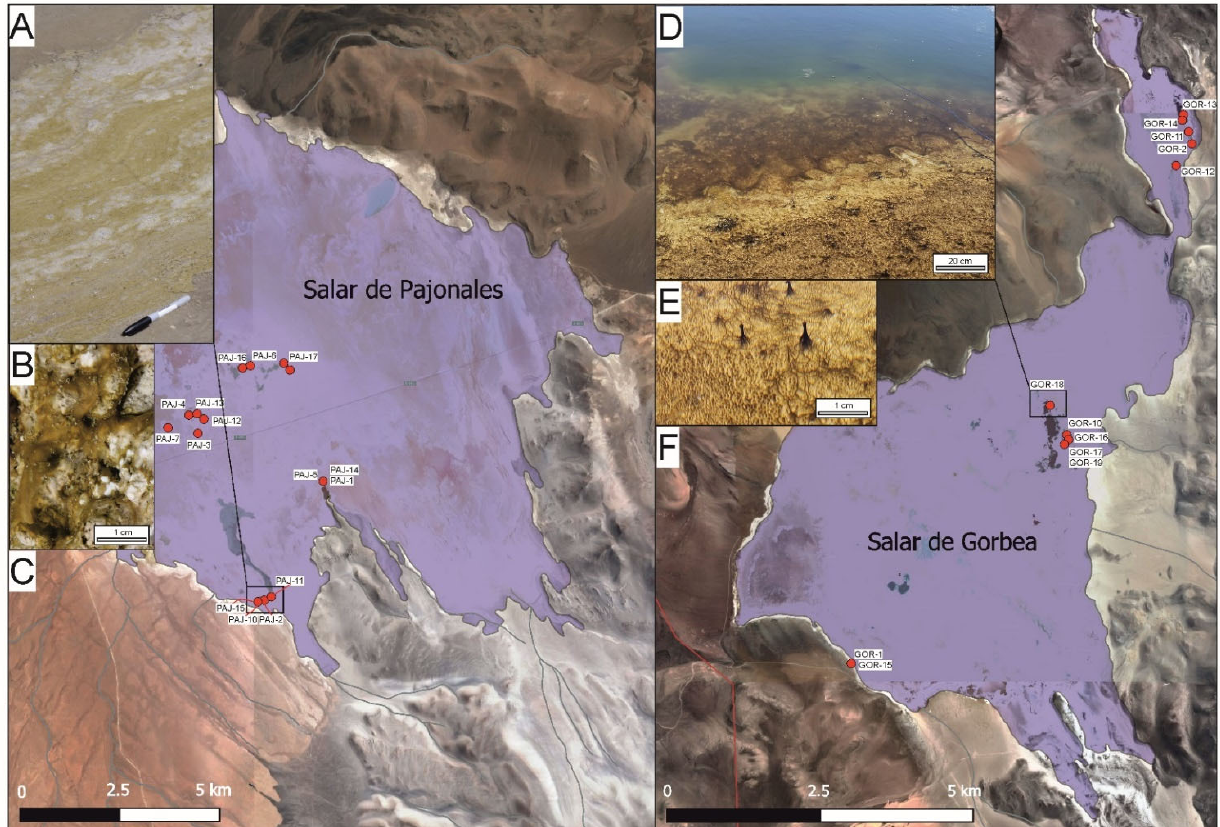
Figure 3. Field photographs showing a representative sample area surrounding the ponds (darker blue zones in the map) of Salar de Pajonales ( A ), a detailed view of sediments in the sampled area ( B ), and a view showing the location of sampling points (red dots) in QGIS 3.12.3 ( C ). Imagery from Google Satellite. The same type of photographs and a map for Salar de Gorbea ( D – F ). Note the slimy appearance of dark green microbial mats in the surface of the sediments ( A , B , D , E ). The salar area is overlayed in purple, and grey lines correspond to drainage networks in ( C , F ). Dark areas inside the purple layer are water bodies, whereas the other parts are mainly sediments.